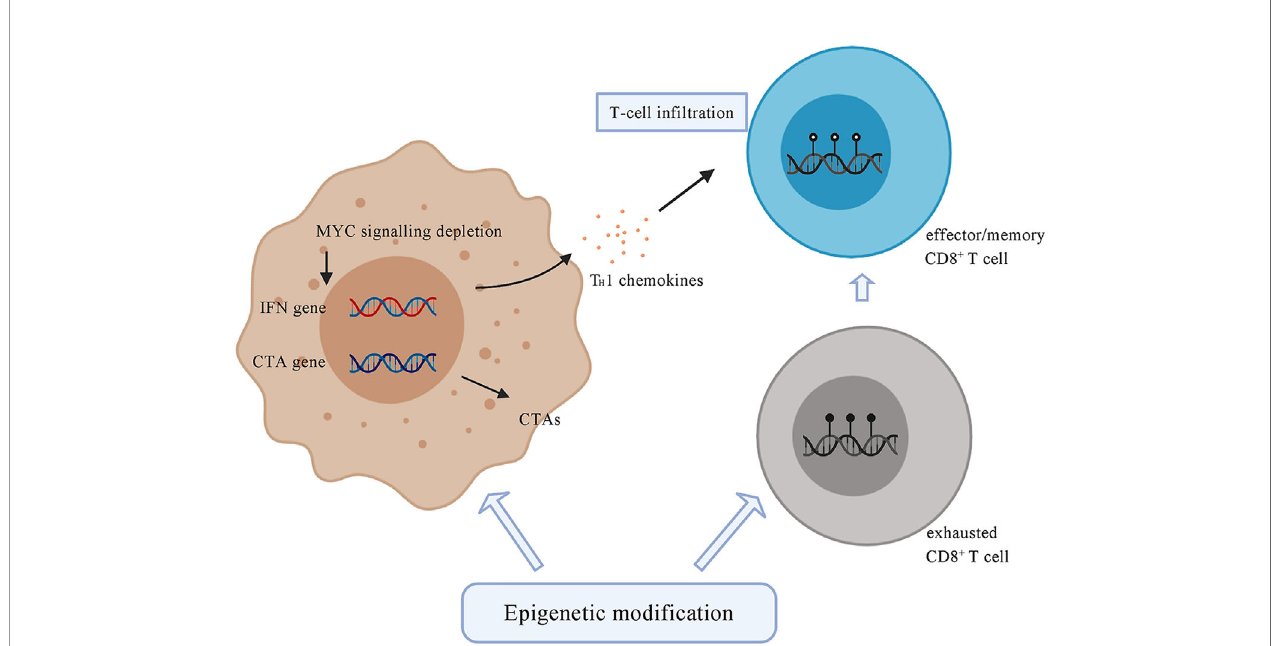
FIGURE 3 | Tumor cells under the treatment of epigenetic drugs upregulate the expression of CTAs, such as NY-ESO-1 and LAGE. Epigenetic modi fi cation contributes to the depletion of MYC signalling, activates type I interferon signalling and potentiates the recruitment of T cells. Epigenetic agents can modulate the state of CD8 + T cells by transforming exhausted CD8 + T cells, which are characterized by a series of changes in effector genes associated with alterations in methylation, into effector or memory CD8 + T cells. CTA, cancer testis antigens; NY-ESO-1, New York Esophageal Squamous Cell Carcinoma-1; LAGE, L antigen family